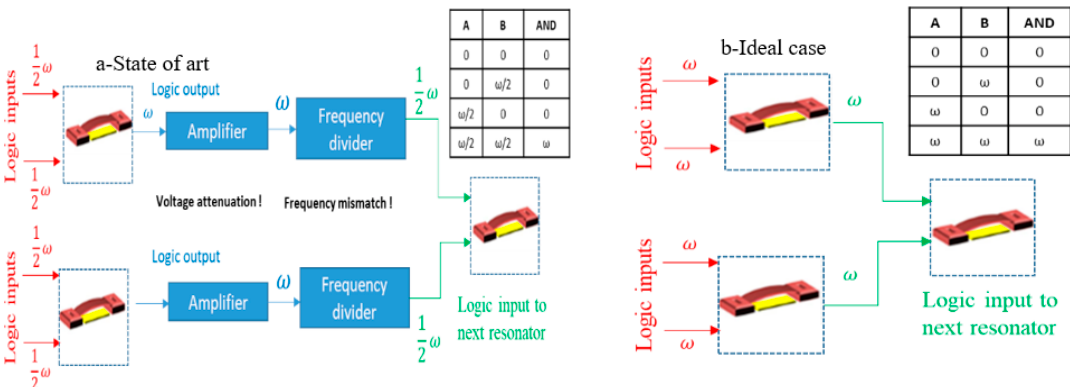
Figure 8. The MEMS cascaded and logic gate. ( a ) The need to use MEMS as the next logic gate led to the proposition of adding very complex complementary metal-oxide-semiconductor (CMOS) chips to enable the cascading MEMS-based logic gate. ( b ) Ideally, we want to achieve CMOS functionalities using MEMS only.